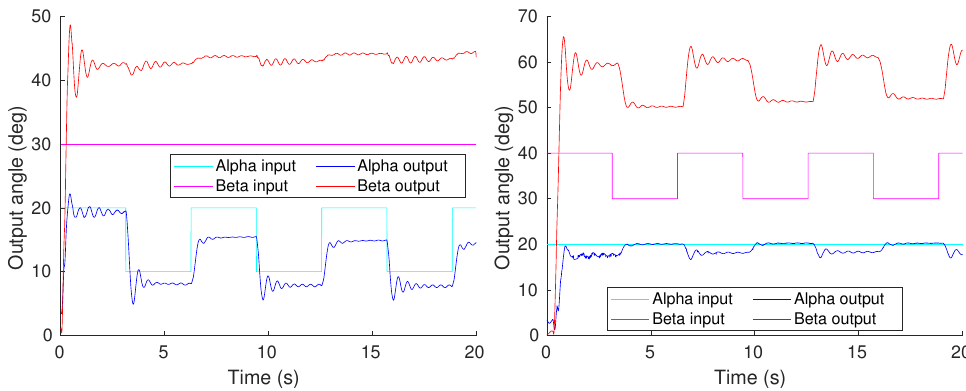
Figure 3. Two examples of identification experiments. The left figure shows the system response to variations in the input α i , while the other inputs are kept constant ( β i = 30 and l i = 0). Right figure shows the system response to variations in the input β i , while the other inputs are kept constant ( α i = 20 and l i =